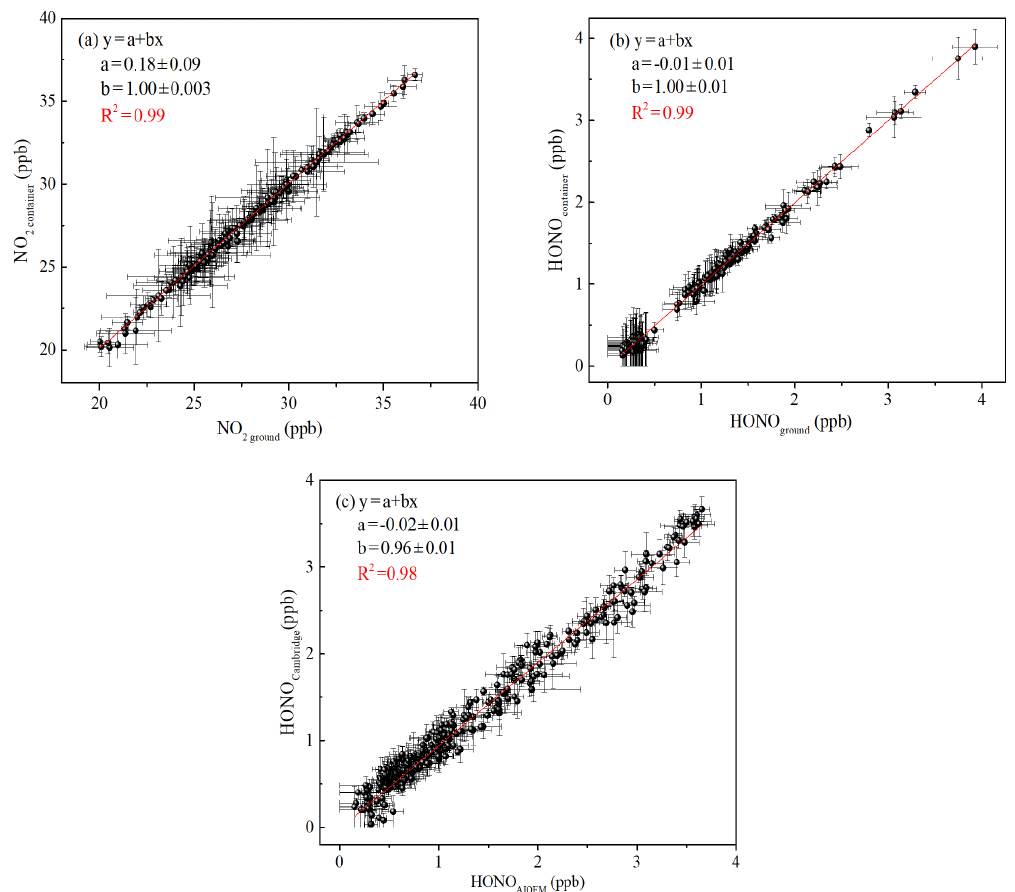
Figure 2. (a) Correlation of NO 2 concentration was measured using the two IBBCEAS instruments; (b) correlation of HONO concentration was measured using the two IBBCEAS instruments; (c) an inter-comparison between the IBBCEAS of Cambridge University and the IBBCEAS of the Anhui Institute of Optics and Fine Mechanics (AIOFM). The solid lines (red lines) show the orthogonal linear least squares regression between the two IBBCEAS